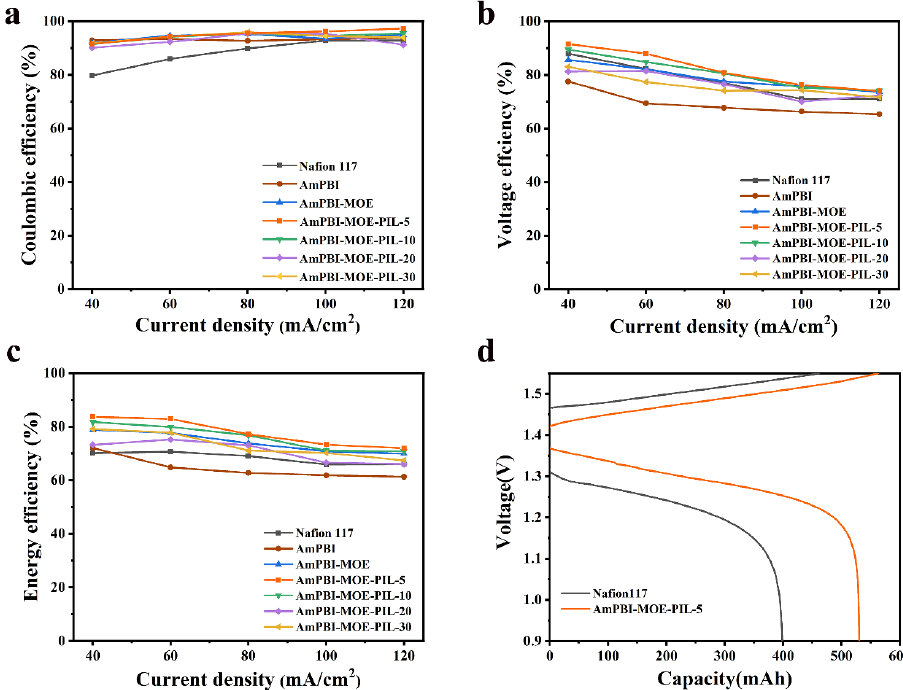
Figure 6. Cell performances ( a ) CE, ( b ) VE, ( c ) EE of AmPBI-MOE-PIL-X and Nafion117 membranes, charge–discharge curve ( d ) at 60 mA · cm − 2 . Table 2. Performances of several batteries with various functionalized PBI membranes.